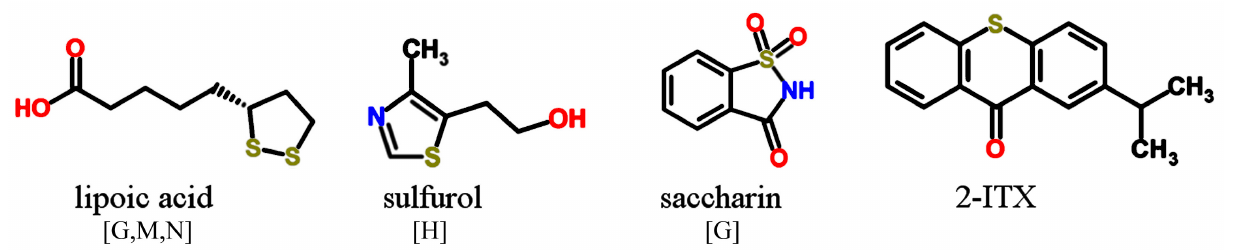
Figure 7. S -containing cyclic structures detectable in GC-MS profiling experiments. MS spectra included in publically available